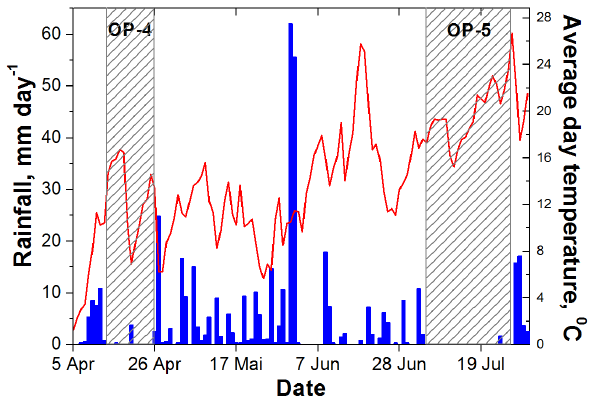
Figure 4. Diurnal rainfall and mean temperature during the 2013 growing season. Hatched zones (OP-4, OP-5) indicate periods with low amount of rain and